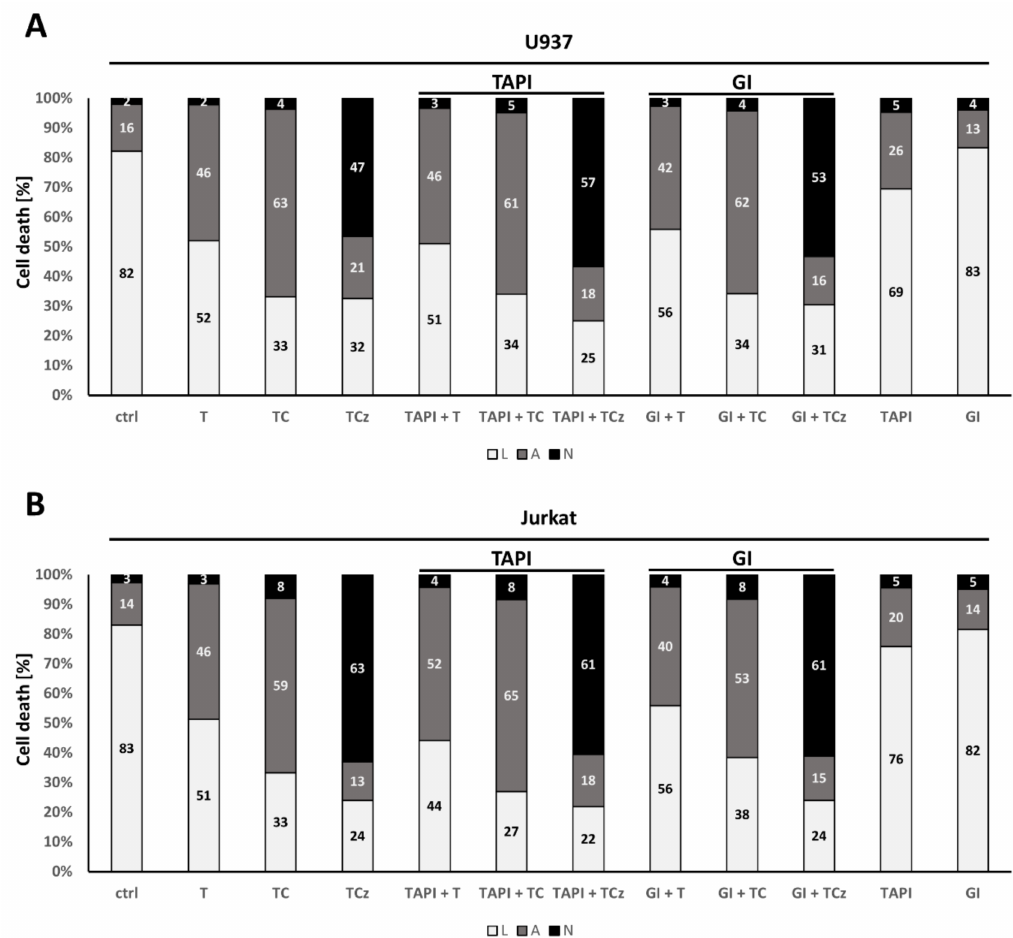
Figure 2. Analysis of cell death induction in human U937 and Jurkat cells upon pharmacological inhibition of ADAM17 and ADAM10. Quantification of cell death induction is depicted for ( A ) U937 and ( B ) Jurkat cells. Where indicated, cells were incubated for 20 h in the presence of the ADAM17 inhibitor TAPI-0 (TAPI) or the ADAM10 inhibitor GI254023X (GI). Both were added 30 min prior to addition of the death stimulus. The percentage of living cells (L) is shown in white, apoptotic (A) in grey and necroptotic (N) in black. One representative of at least n = 3 experiments is